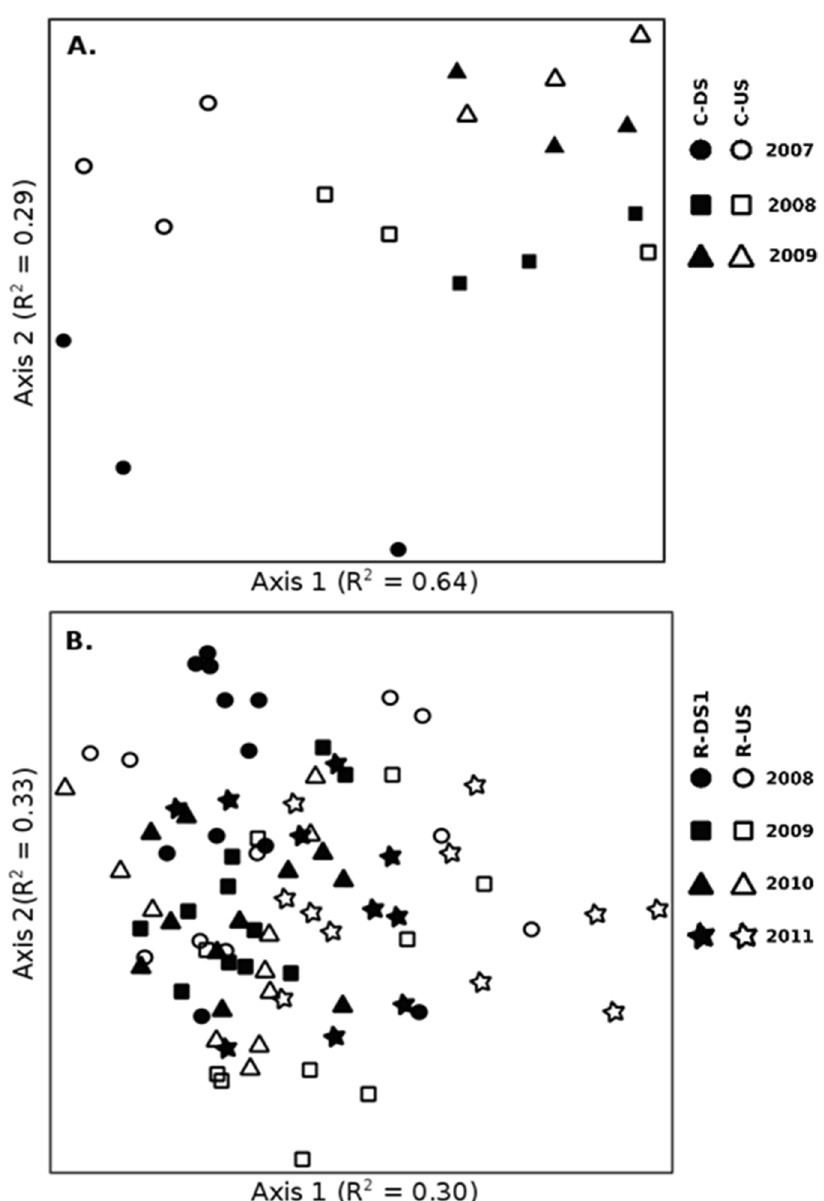
Figure 5. NMS ordination plot according to the taxonomic structure of A) 3 upstream and 3 downstream riffles associated with the Brownsville Dam removal on the Calapooia River over three collection years, and B) 11 upstream and 11 downstream transects associated with the Savage Rapids Dam removal on the Rogue River over four collection years. Note that the 11 transects from reach ‘‘DS2’’ have been removed from the figure to reduce clutter (see Table 3 for MRPP analysis of these data, including the DS2 reach). A) Final stress for the two-dimensional solution=10.1. B) Final stress for a three-dimensional solution was 15.2, and the unpictured third axis had R 2 =0.21.